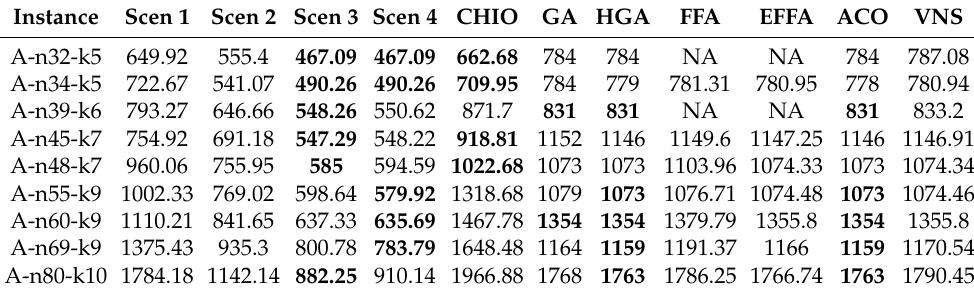
Table 1. Comparison of the four proposed scenarios and data from publication